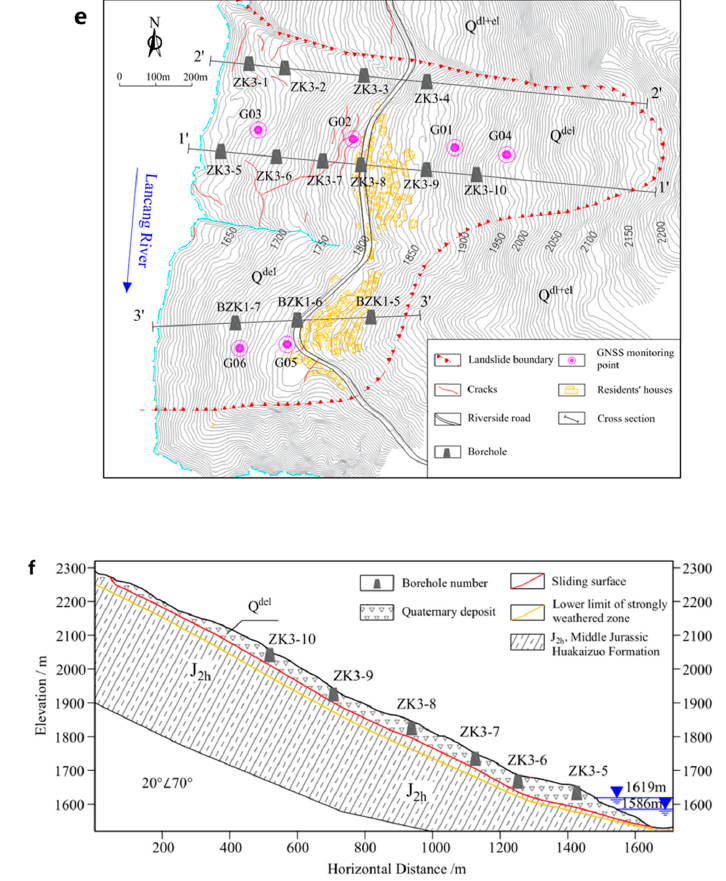
Figure 1. The Cheyiping landslide in the reservoir area of Huangdeng Hydropower Station: ( a ) Geographic location of the study area. ( b ) Aerial view of the Cheyiping landslide and locations of three cross-sections; ( c ) Gullies; ( d ) Platform; ( e ) Engineering geological map of the landslide; ( f ) Geological cross section alone profile 1-1 ′ .